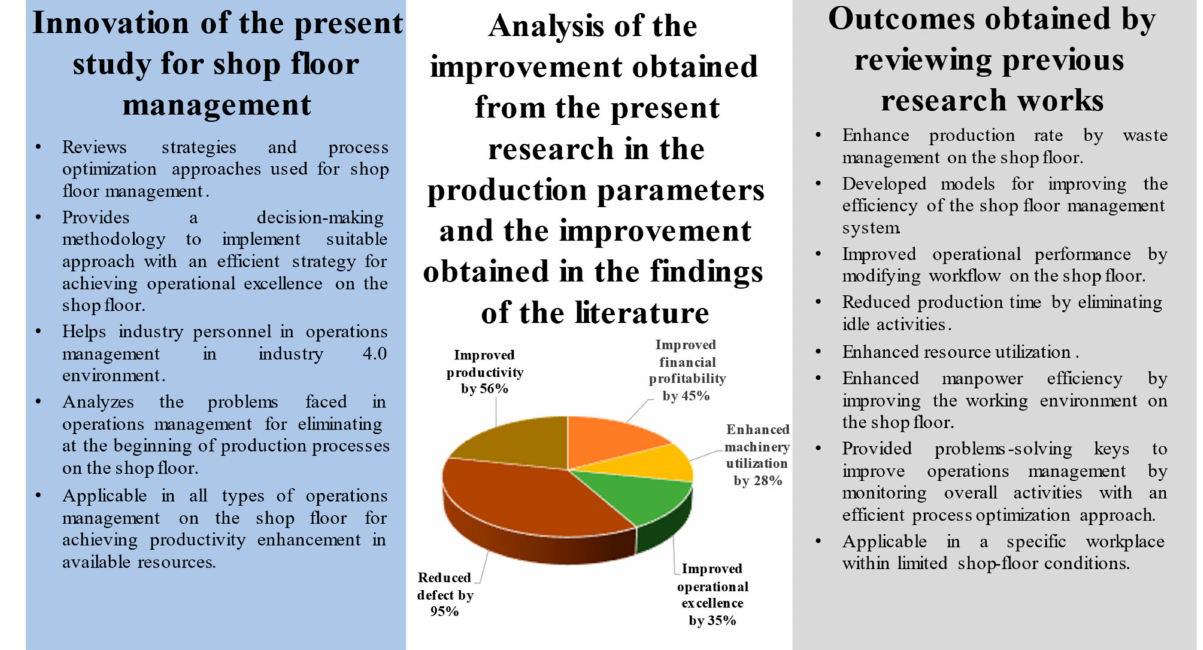
Figure 14. Comparison of the present study with previous research